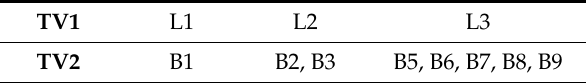
Table 2. The elements of topology vectors.